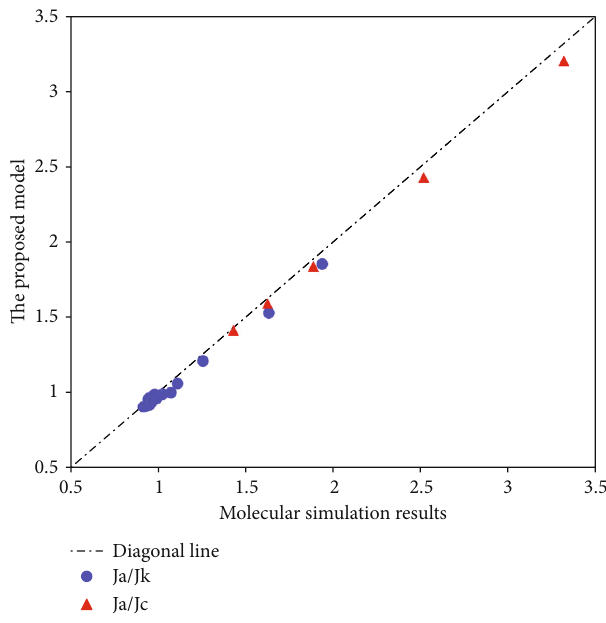
Figure 5: The comparison between proposed model and molecular simulation results.